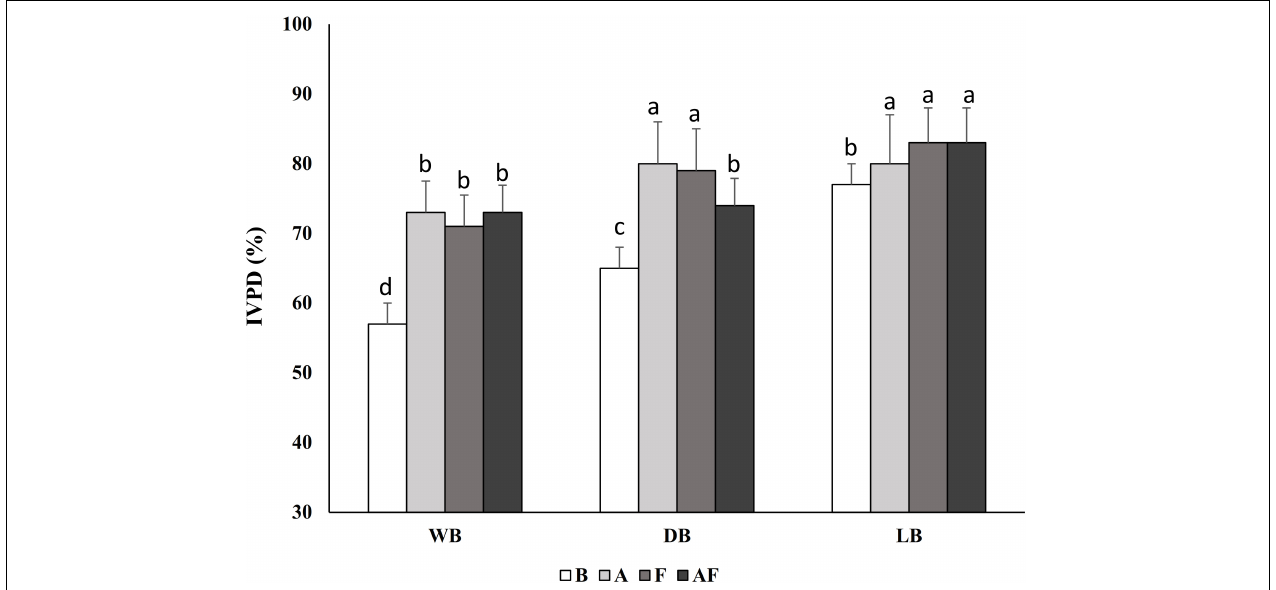
FIGURE 1 | In vitro protein digestibility (IVPD) of wet (WB), dried at low temperature (DB), and lyophilized (LB) Spirulina biomass. All biomasses were also treated with Alcalase R (cid:13) (A, 1% vol/wt), fermented with Lactiplantibacillus plantarum T0A10 (F, final cell density of circa 7 log10 cfu/g), or fermented and treated with Alcalase R (cid:13) (AF). Enzymatic and microbial treatments were carried out at 30 ◦ C for 24